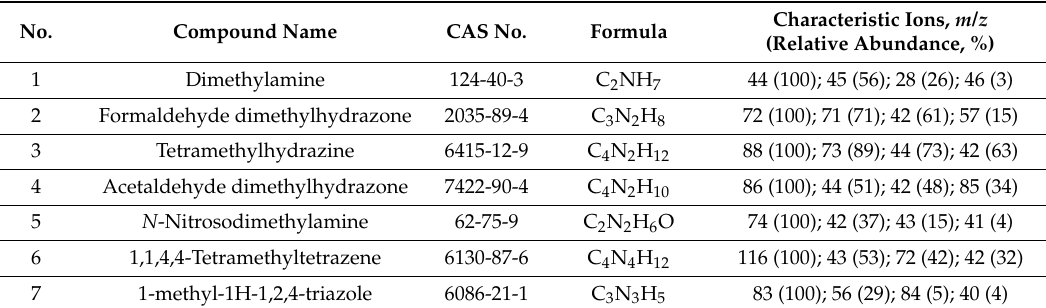
Table 2. The list of transformation compounds of unsymmetrical dimethylhydrazine (UDMH) detected in aqueous mineral salt medium (MSM) and